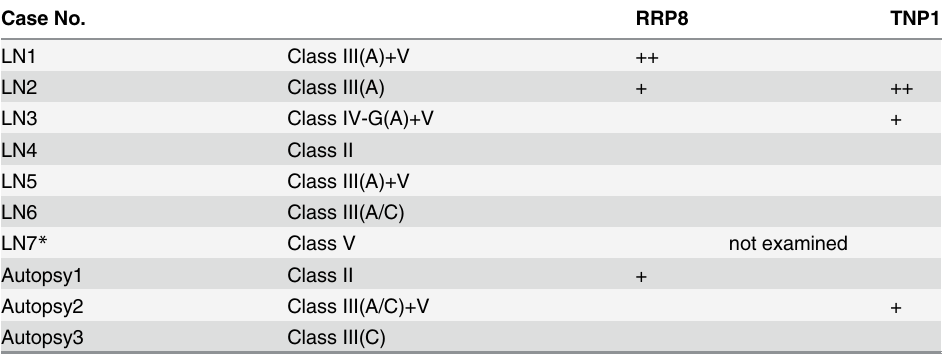
Table 2. Deposition of RRP8 and/or TNP1 in renal sections obtained by biopsy and autopsy from LN patients. Case No.